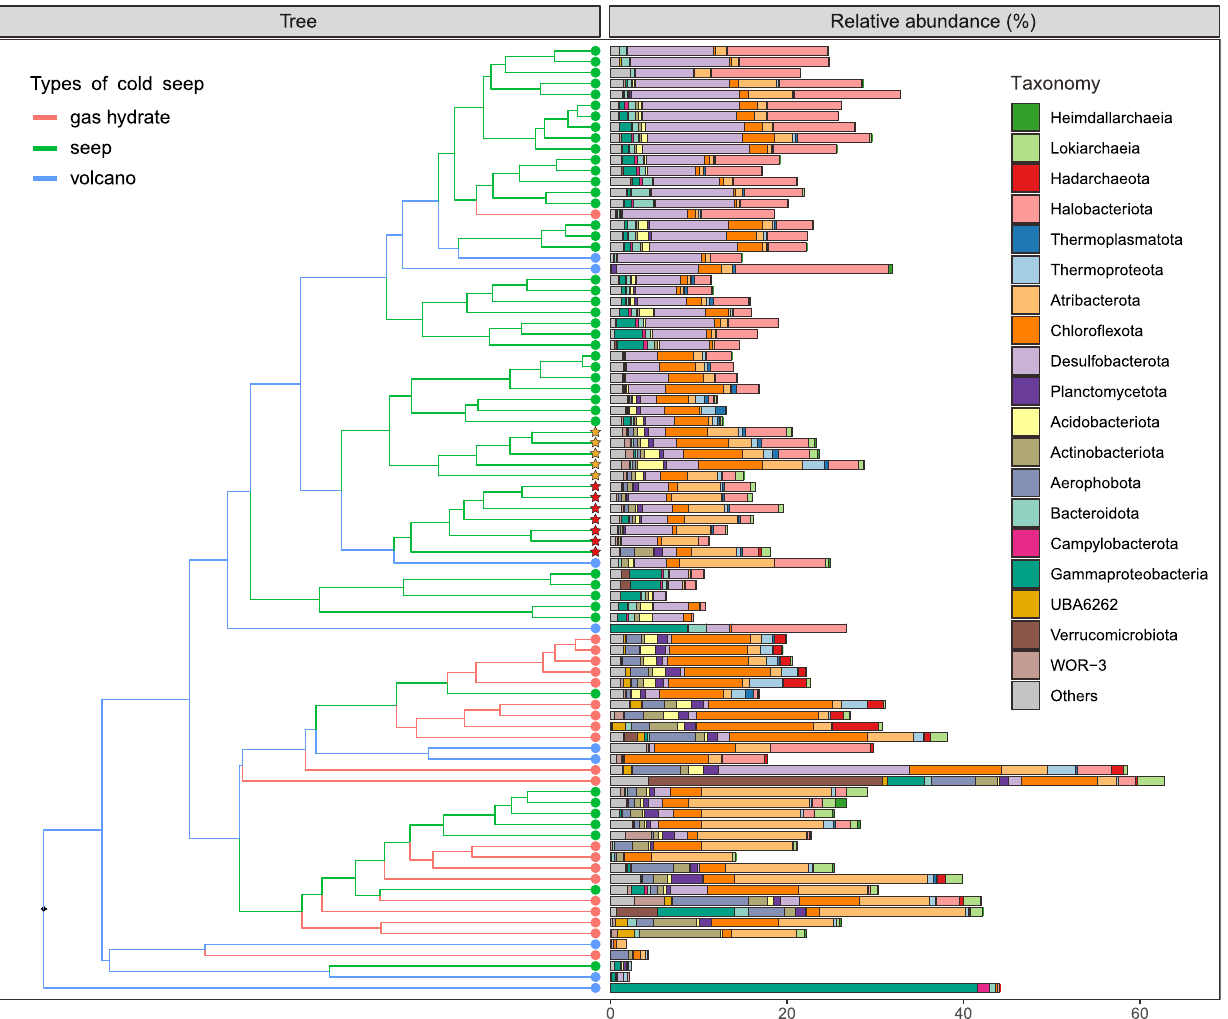
Fig. 3 The community structures of microbiome involved in As cycling at cold seeps. The relative abundance of each MAG was estimated using CoverM. The compositions of microbiome involved in As cycling across different types of cold seep were clustered based the Bray – Curtis distance. Orange and red asterisks denote samples with lower and higher concentrations of Fe(II), respectively. Detailed statistics for As-related microbiome are provided in Supplementary Data